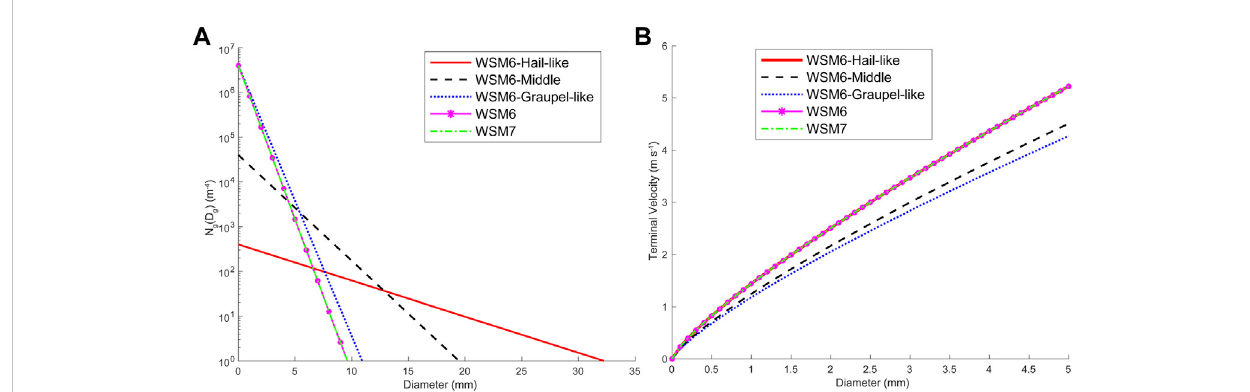
FIGURE 2 (A) Therelationshipofgraupelhydrometeordiametersandnumberconcentrationwithgraupelmixingratioof1 gkg − 1 andairdensityof1 kgm − 3 . (B)